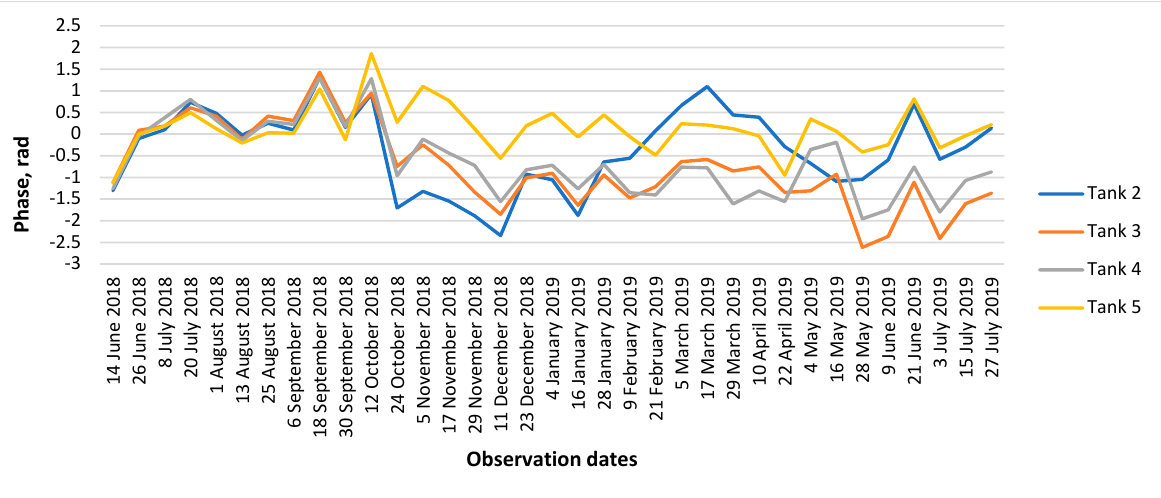
Figure 14. Accumulation of the phases for tanks 2–5 in 2018–2019.